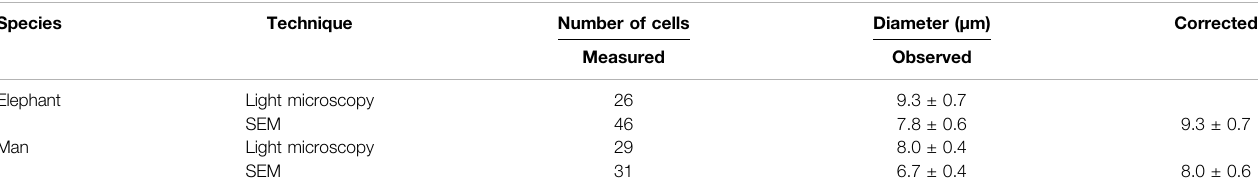
TABLE 2 | Diameter of elephant RBC compared with human RBC.